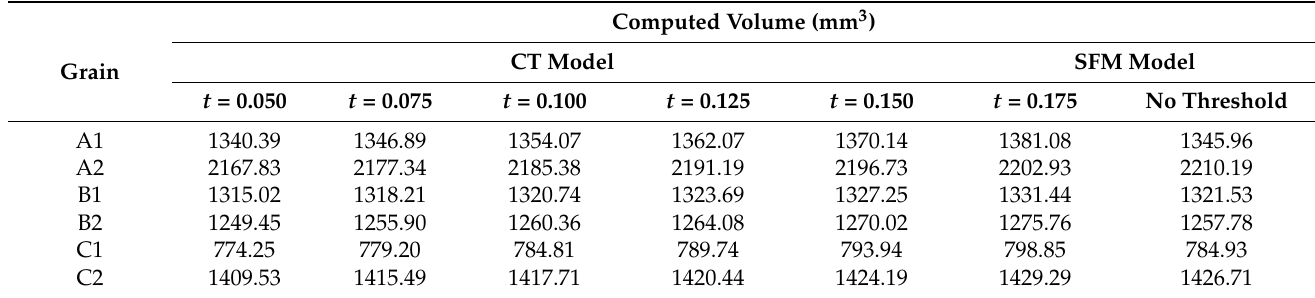
Table 2. Volume of grains computed with different methods and different thresholds applied.